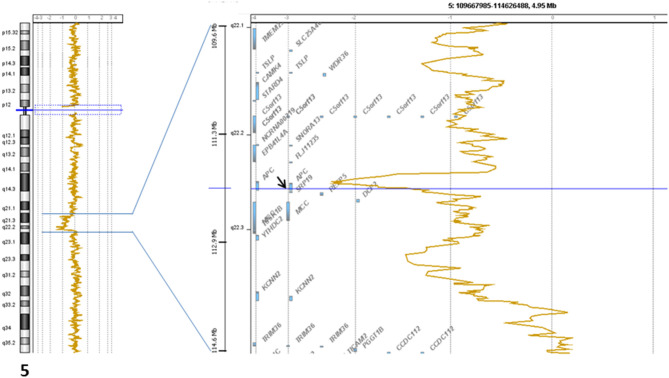
Genomic profile of the 5q22.2 chromosomal region showing the breakage in APC gene.